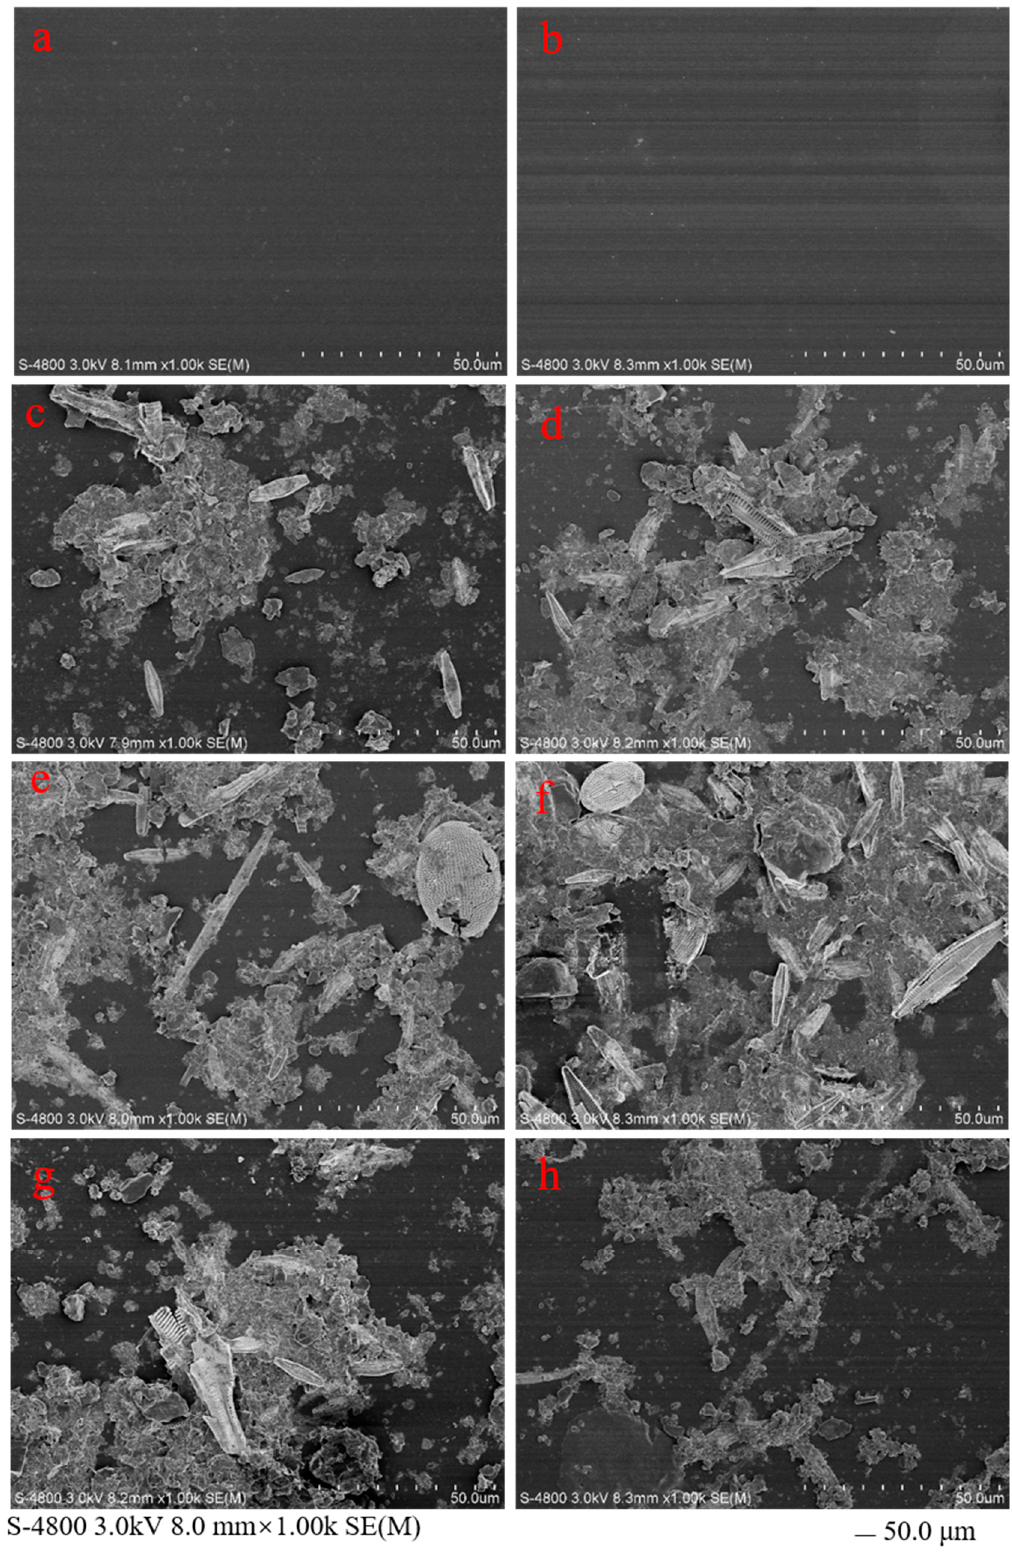
Figure 1. SEM images of plastic debris. ( a ) Virgin PP; ( b ) virgin PET; ( c ) biofilm-covered PP in Xuanwu Lake; ( d ) biofilm-covered PET in Xuanwu Lake; ( e ) biofilm-covered PP in Donghu Lake; ( f ) biofilm-covered PET in Donghu Lake; ( g ) biofilm-covered PP in Qinhuai River; and ( h ) biofilm- covered PET in Qinhuai River.